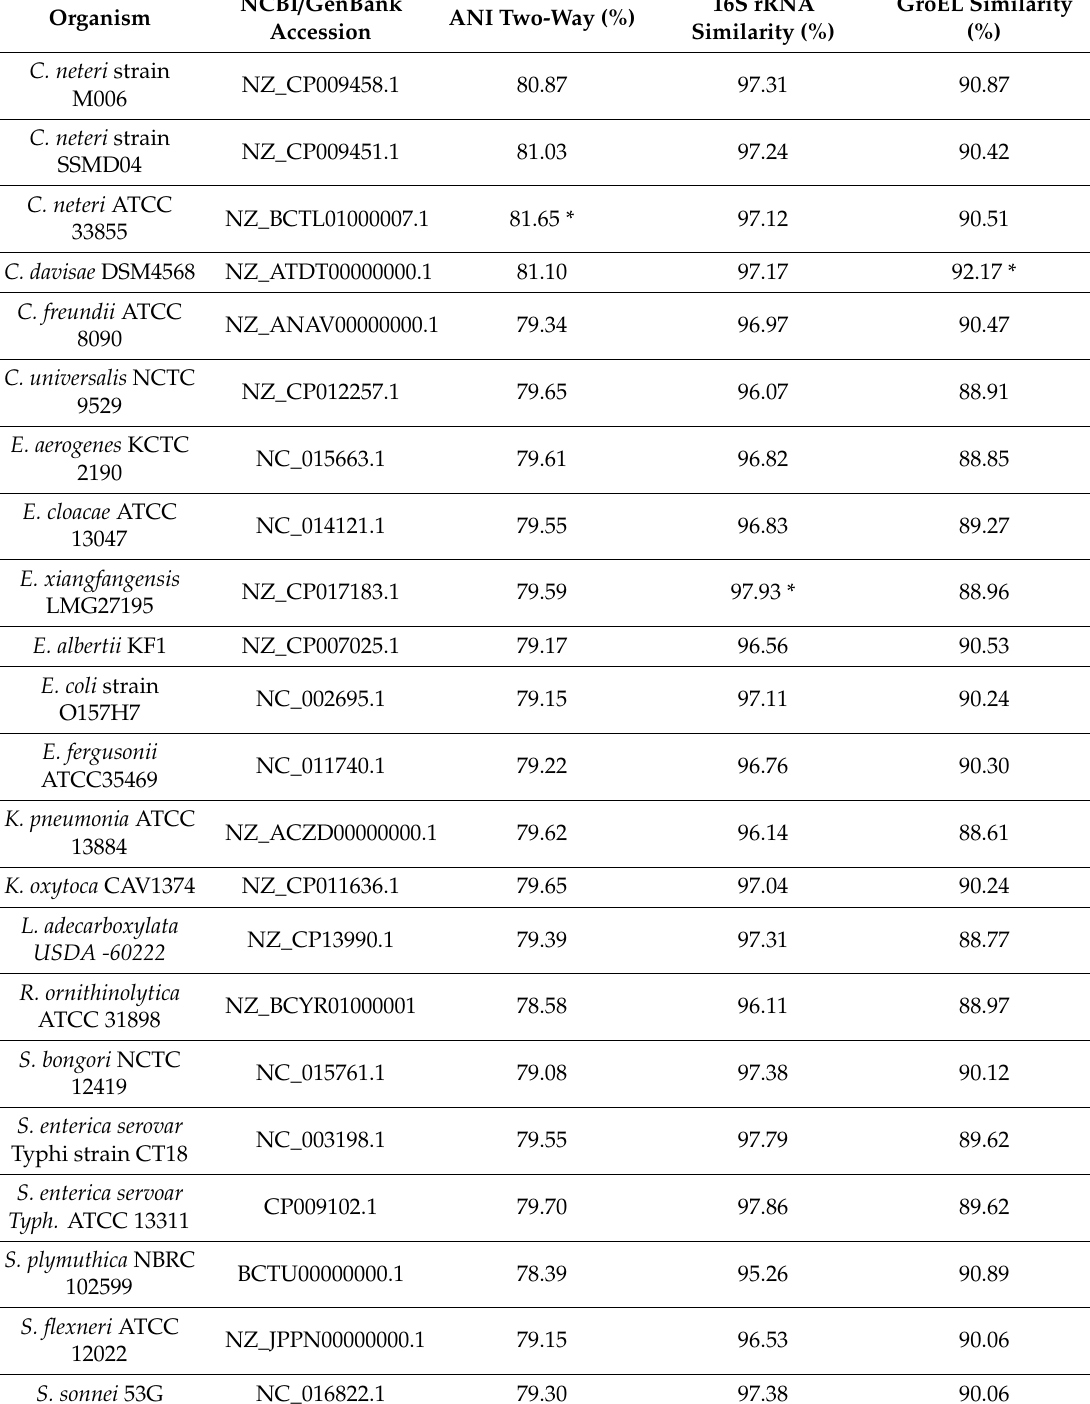
Table 1. In silico phylogenetic characterisation comparing strain ZA_0188 T with other Enterobacteriaceae